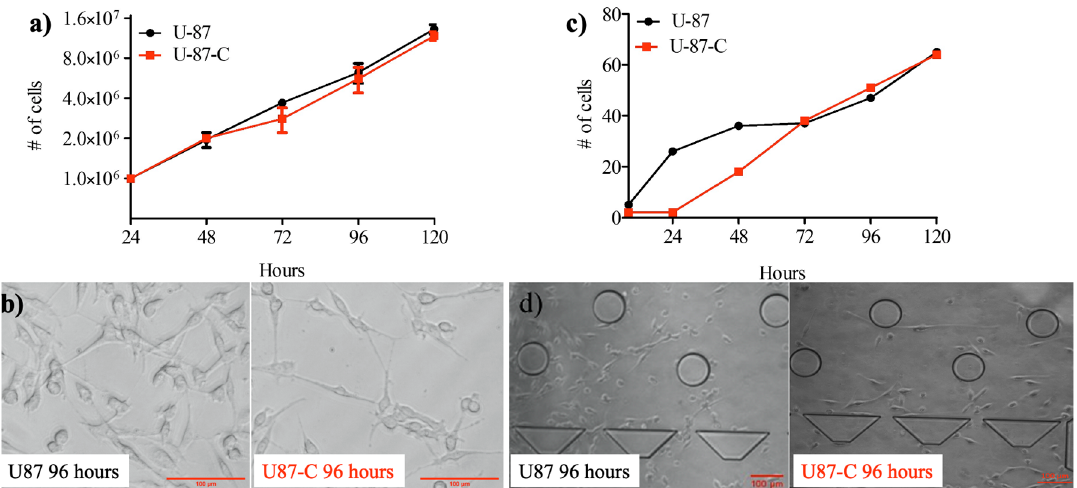
Figure 2. Growth comparison. Glioma cells were grown in DMEM medium (U87) and in 50% DMEM and 50% macrophage-depleted medium (U87-C) in the 6-well culture dish and microfluidic platform. ( a ) The number of viable cells for five days in a 6-well plate, ( b ) the micrographs of U87 and U87-C cells for a 96-h growth. The scale bar shows 20 μ m. ( c ) The number of viable cells for five days in the microfluidic device, ( d ) micrographs of glioma cells for the 96-h growth. The scale bar shows 100 μ m. The number of cells present the mean ± standard error for two independent experiments.